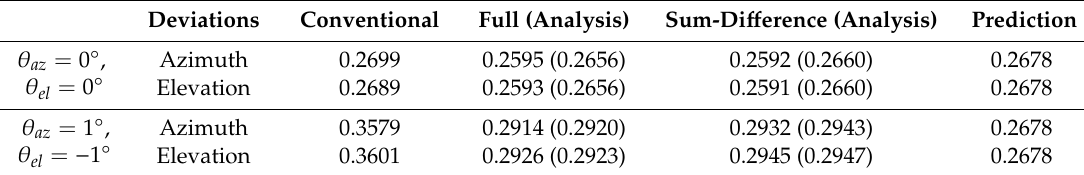
Table 2. RMS errors for target locations: θ 3 dB = 3 ◦ , θ s = 1 ◦ , σ = 0.1 ◦ .